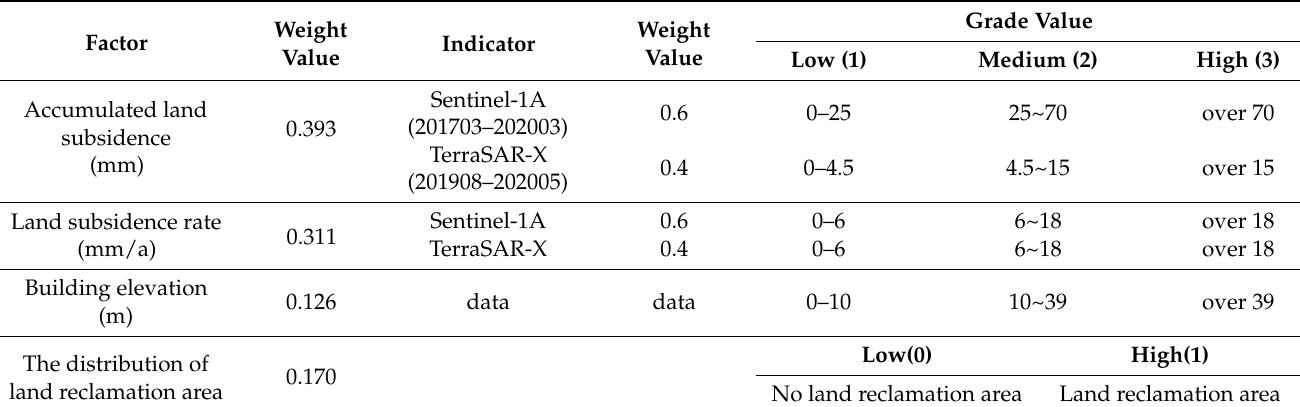
Table 5. Factors for indices to assess land subsidence